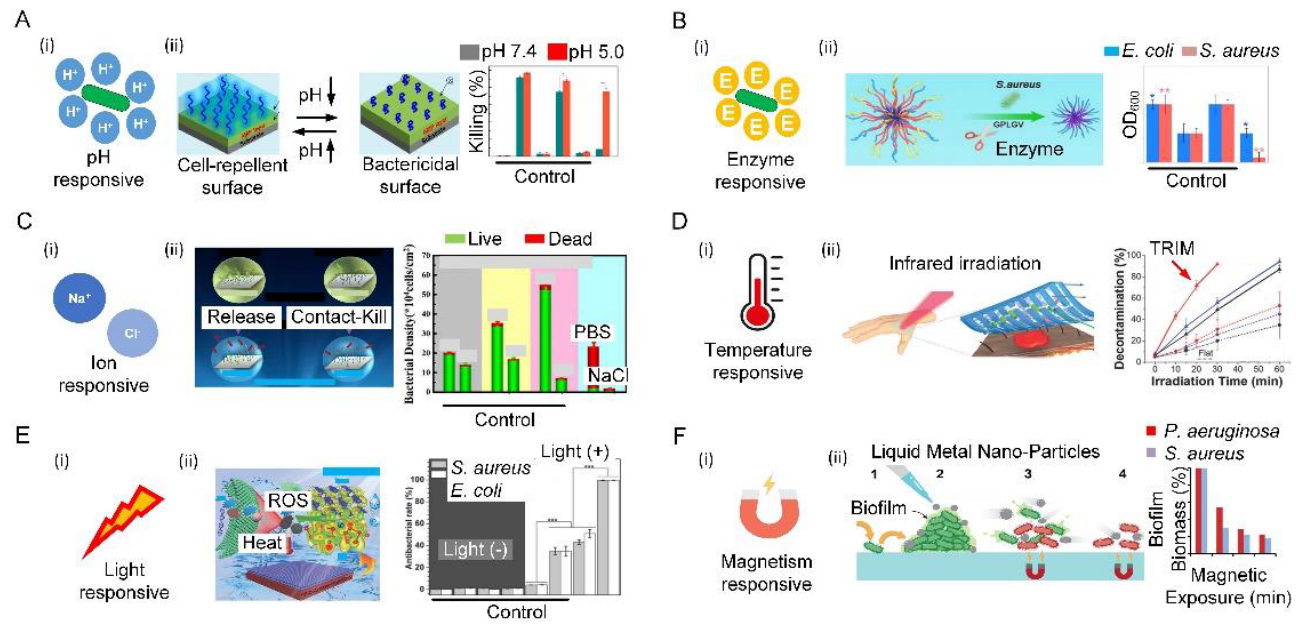
Figure 6. Bioinspired responsive surfaces. ( A ) Schematic illustration of pH-responsive antibacterial surfaces (i) a hierarchical surface, when bacteria colonize surfaces, bacteria-induced acidification collapses the outermost poly (methacrylic acid) chains, thereby exposing the underlying antimicro- bial peptides to kill bacteria on demand. Additionally, dead bacteria can be released after the PMAA chains recover hydrophilicity due to an increase in ambient pH (ii). Reproduced with permission [140]. 2016, American Chemical Society (United States). ( B ) Schematic diagram of the enzyme-re- sponsive antibacterial surface (i) illustration of the bio-interface with enzyme-responsive, antibac- terial, and cell-adhesion functions for tissue engineering (ii). Reproduced with permission [141]. 2021, Elsevier. ( C ) Schematic diagram of ion-responsive antibacterial surface (i) salt-responsive poly(3-(dimethyl(4-vinylbenzyl) ammonio) propyl sulfonate), antifouling poly (N-hydroxyethyl